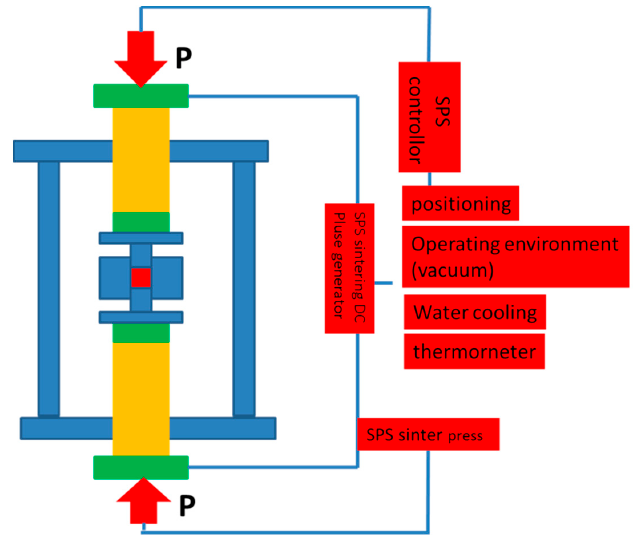
Figure 1. Diagram of spark plasma sintering (SPS) system for preparing composite compacts in this work.